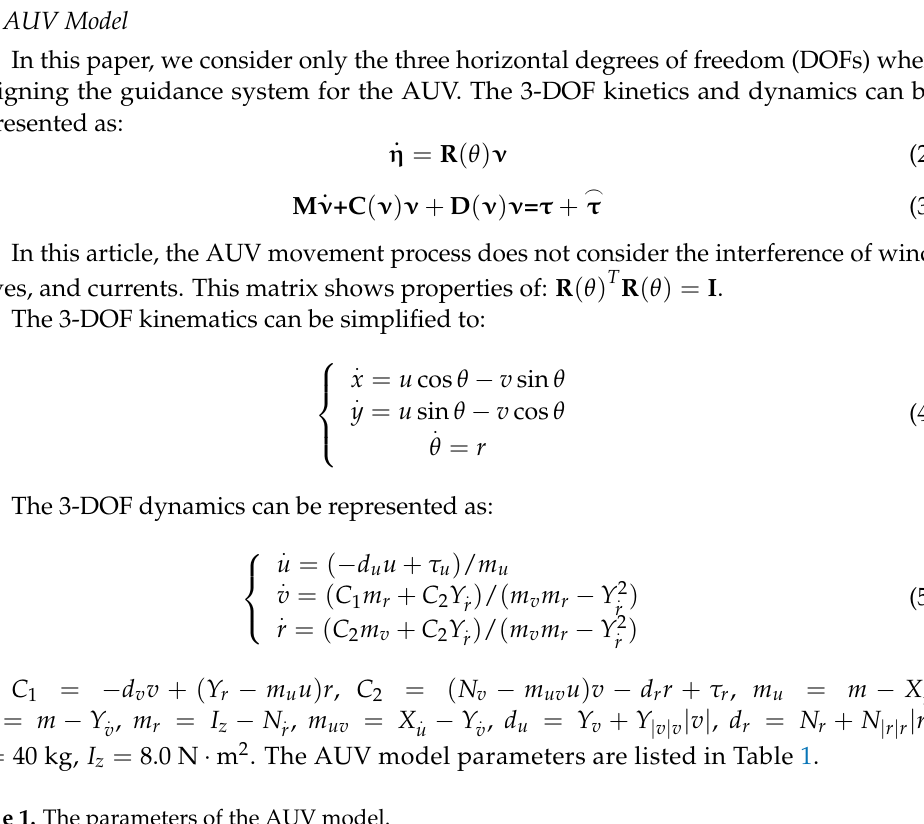
Table 1. The parameters of the AUV